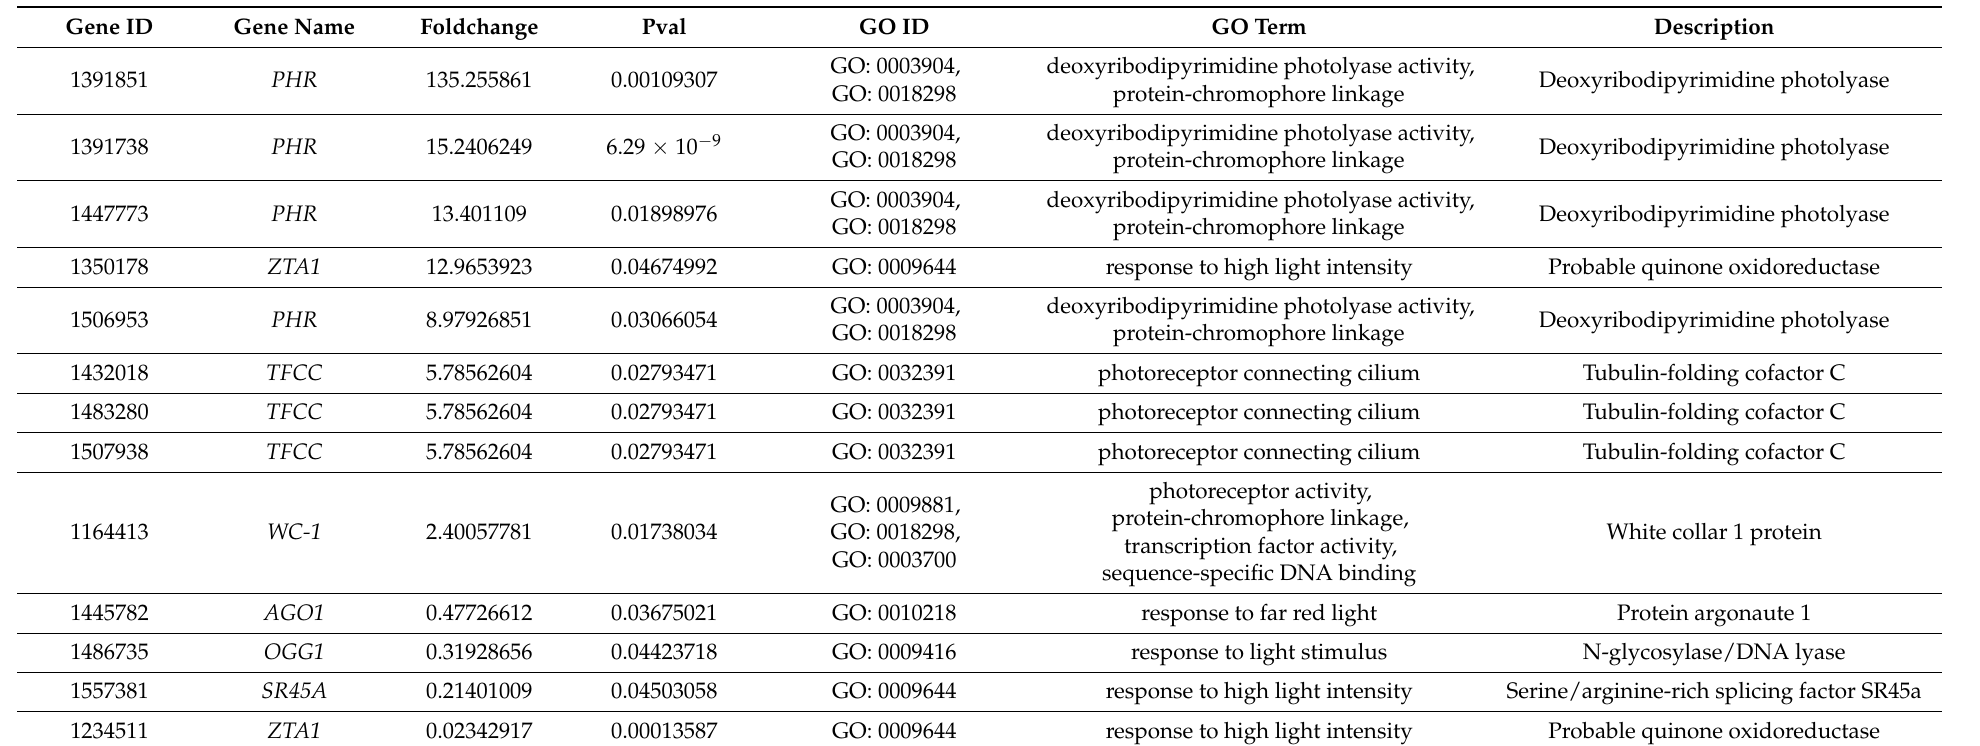
Table 2. DEGs enrich to GO terms related to